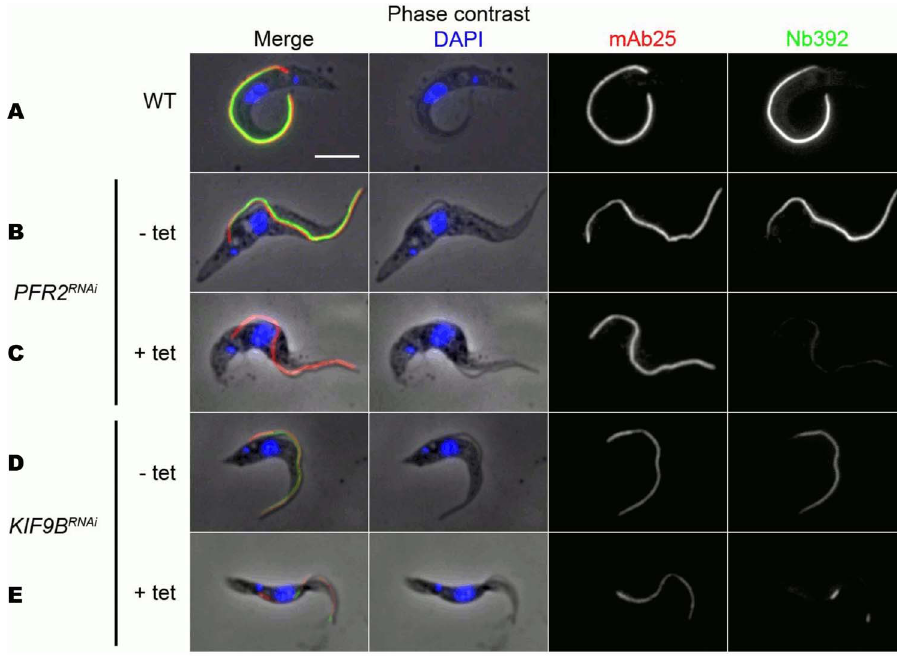
Fig. 5. Immunofluorescence assay on T. brucei procyclic cells showing reactivity of Nb392 in two PFR mutants. Horizontal rows from top to bottom: Wild type (A) PFR2 RNAi uninduced (B), PFR2 RNAi induced (C), KIF9B RNAi uninduced (D), KIF9B RNAi induced (E), Vertical columns from left to right: combined phase-contrast DAPI, mAb25 and Nb392 images (left), DAPI images (middle left), mAb25 (middle right), Nb392 (right). Scale bar: 5 m m.